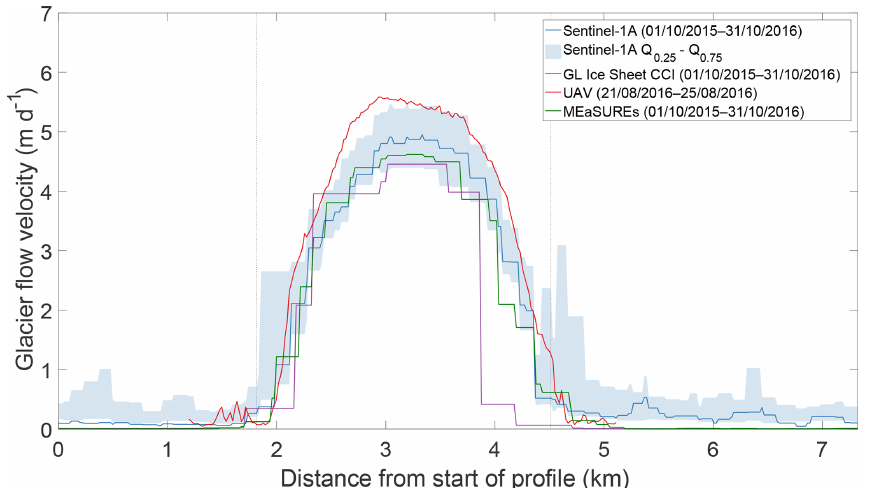
Figure 14. Mean annual flow speed across the glacier tongue (see Fig. 1) between 1 October 2015 and 31 October 2016 (13 months) for different products, starting at the orographic left side of the glacier. In red, reference flow speed based on the 4d UAV mosaics acquired on 21 and 25 August 2016 is shown. The dashed lines depict the glacier’s margins.